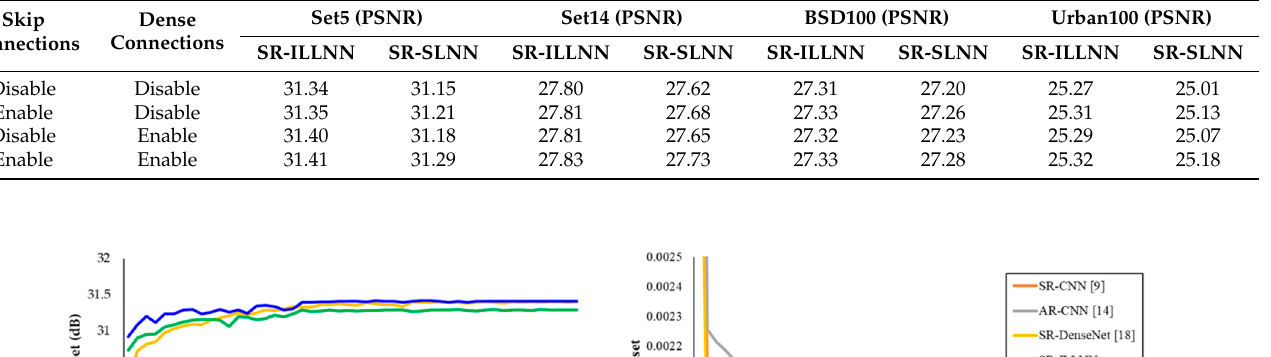
Table 8. The results of tool-off tests.